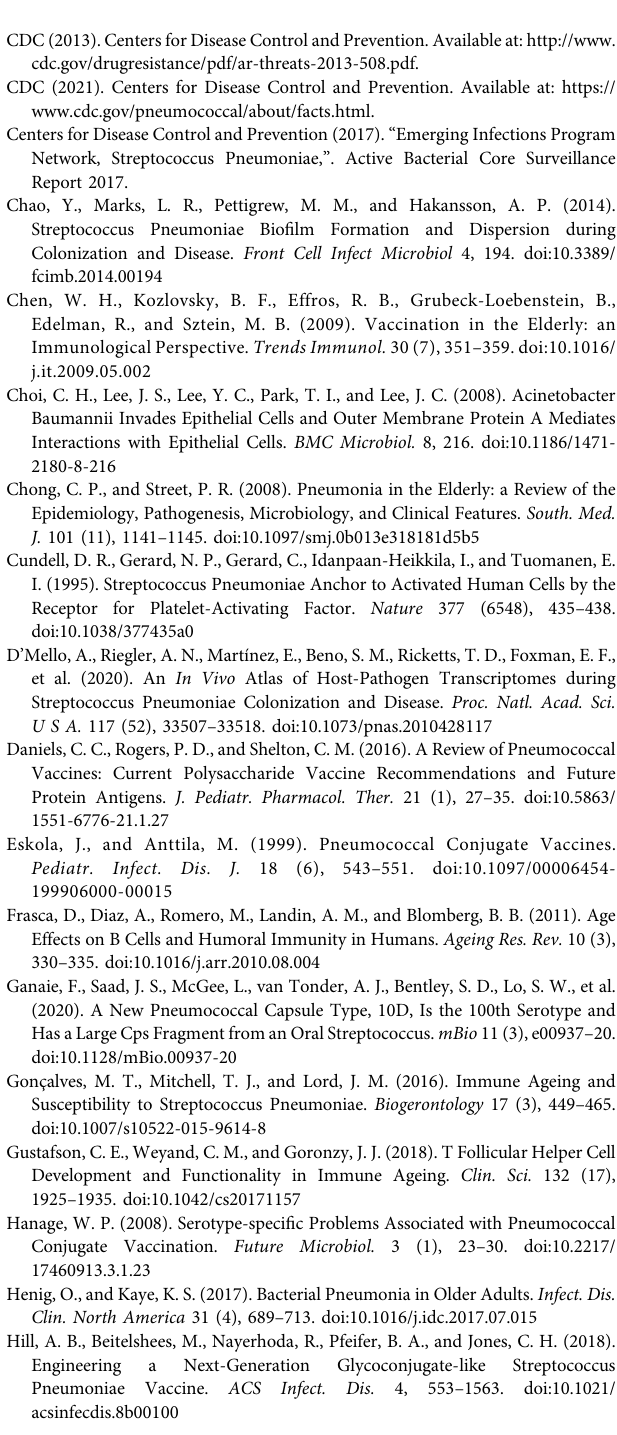
young groups (A-B), data from n (cid:2) 10 mice for Empty LEPS, n (cid:2) 10 mice for LEPS, and n (cid:2) 15miceforPCV13arepooled.Fortheoldgroups(C-D),datafromn (cid:2) 5miceforEmpty LEPS, n (cid:2) 10 mice for LEPS, and n (cid:2) 10 mice for PCV13 are pooled. Supplementary Figure S2 | Effect of different sera on the number of S. pneumoniae bound to pulmonaryepithelial cells. Serawerecollectedfrommice immunizedwithLEPScontainingserotype4capsularpolysaccharideantigen,PCV13,or